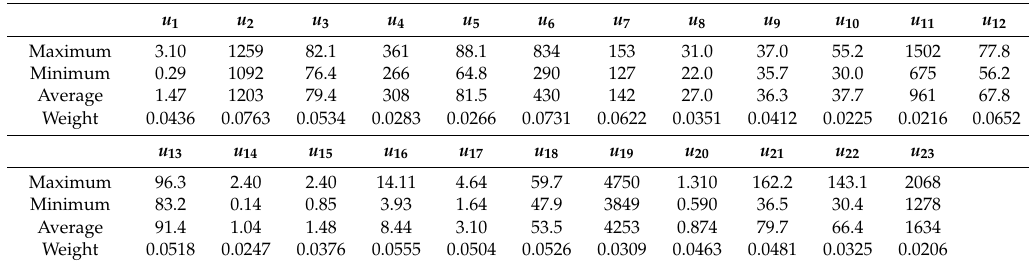
Table 2. The weights of 23 indicators and descriptive statistics.